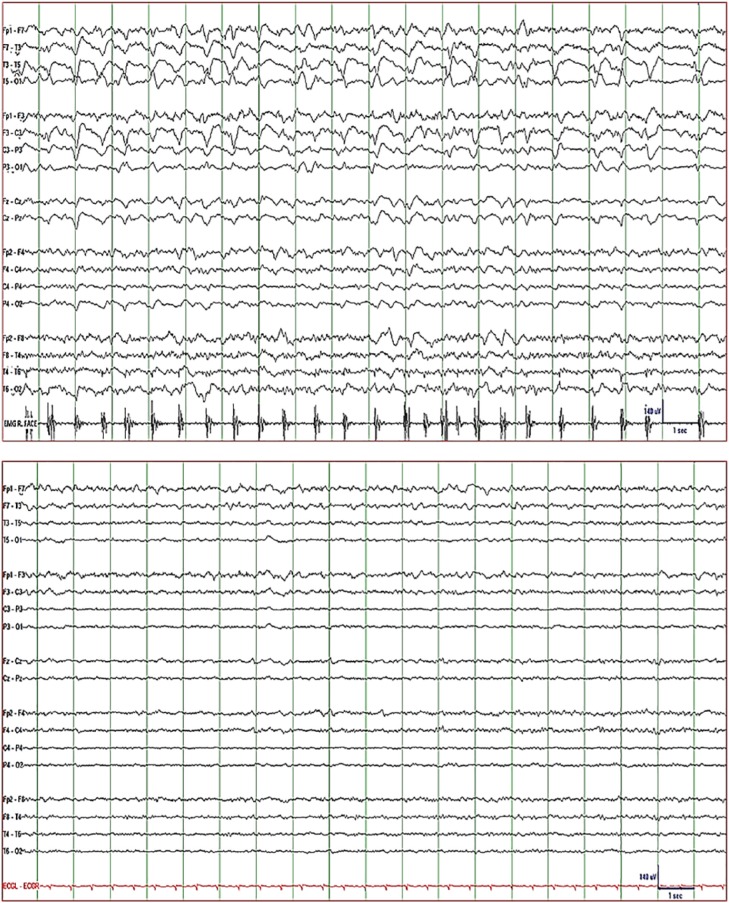
EEG of Patient 2. Top: lateralized periodic discharges
(sharp delta waves) over the left hemisphere time-locked to the myoclonic
jerks of the right hand and face (surface EMG recorded over right face)
consistent with epilepsia partialis continua. Note fluctuation of discharge
rate from 1.5 to 2/s to 0.5 to 1/s. Bottom: electrographic
resolution of periodic discharges 3 days after dexamethasone was added to
conventional antiepileptic therapy coinciding with complete control of
clinical seizures. Display parameters: longitudinal bipolar
montage (from top to bottom: left-mid-right-EMG/ECG), digital filter
bandpass of 1 to 70 Hz, and 60-Hz notch filter turned on; voltage-time scale
is included in the tracing.